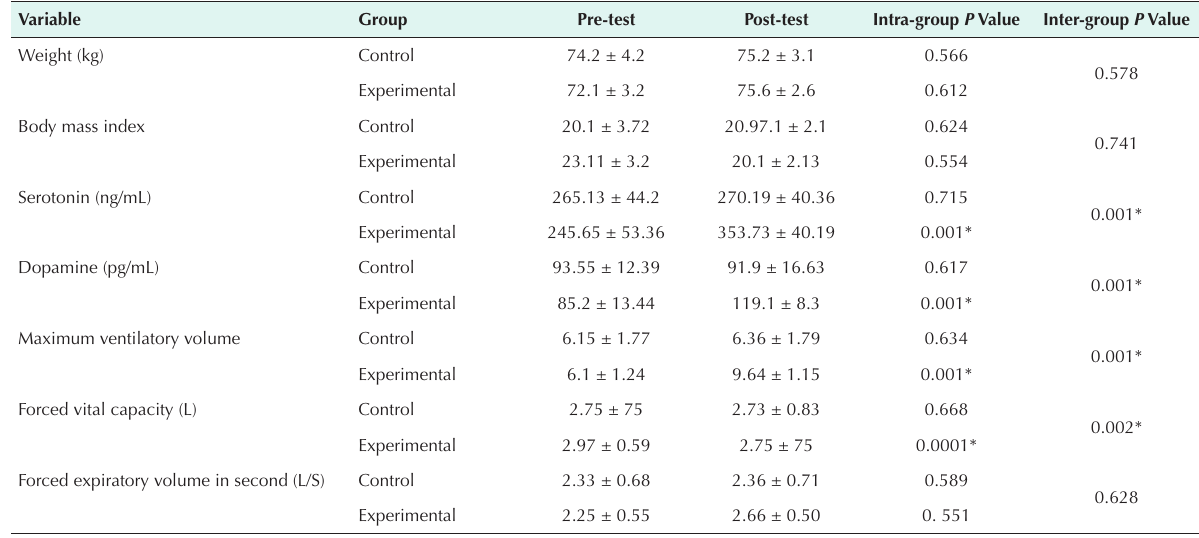
Table 1 . Comparison of Changes Before and After 8 Weeks of Intervention in the Measured Variables in the Resistance Training Group and the Control Group on the Resting Levels of Some Neurotransmitters and Lung Function of Men After the Withdrawal of Addiction